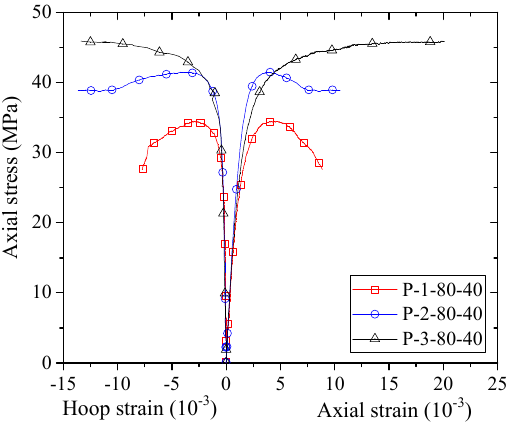
Figure 8. Stress–strain curves of concrete in the Group II specimens.